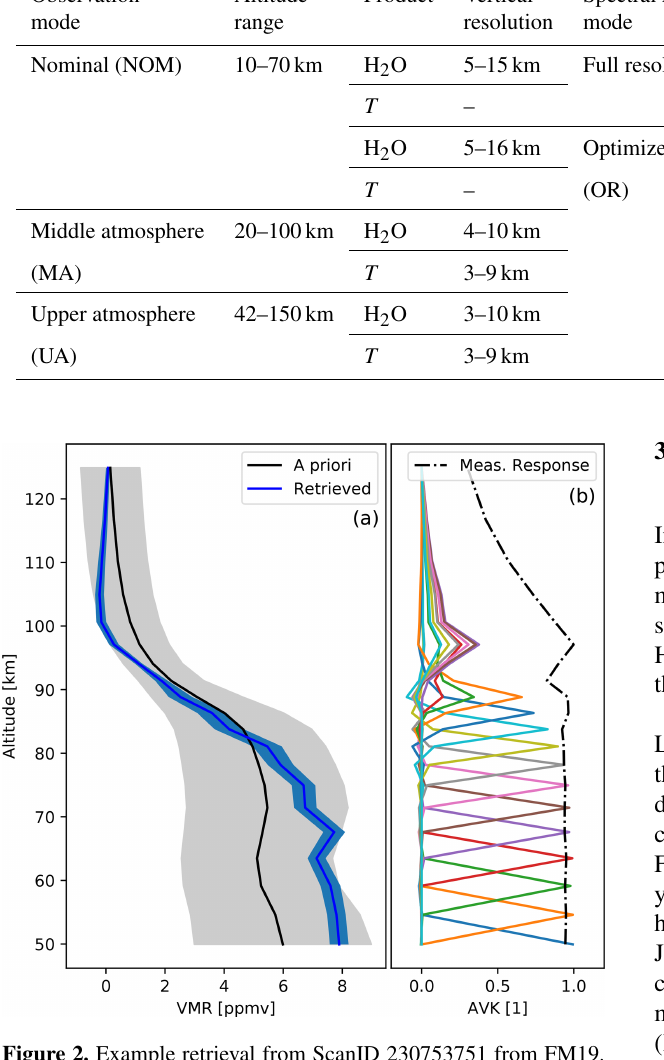
Figure 2. Example retrieval from ScanID 230753751 from FM19. (a) Retrieved mixing ratio profile and error due measurement ther- mal noise (Rodgers, 2000) (in blue and shaded, respectively) and a priori including uncertainties (in black and shaded, respectively). (b) Averaging kernels plotted in a different colour for each altitude (not indicated) and measurement response (dashed–dotted black